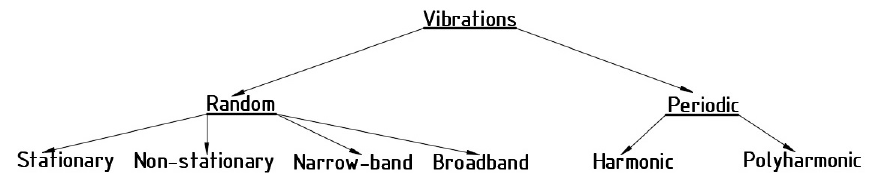
Figure 3. Classification of vibrations.